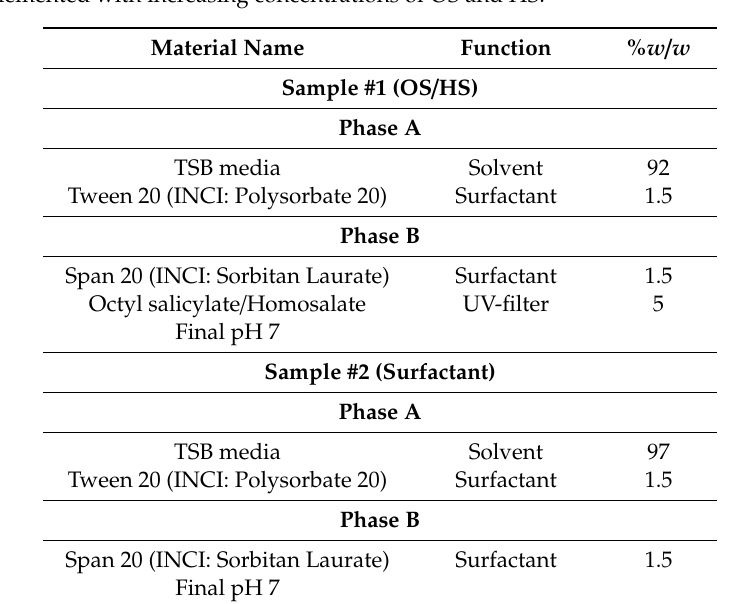
Table 2. Ingredients and formulation design for P. aeruginosa pchD gene expression assay in the TSB media supplemented with increasing concentrations of OS and